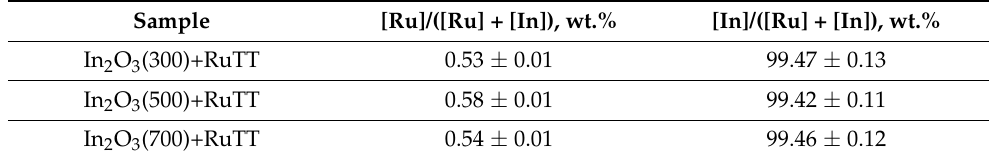
Table 5. Elemental composition of hybrid materials.